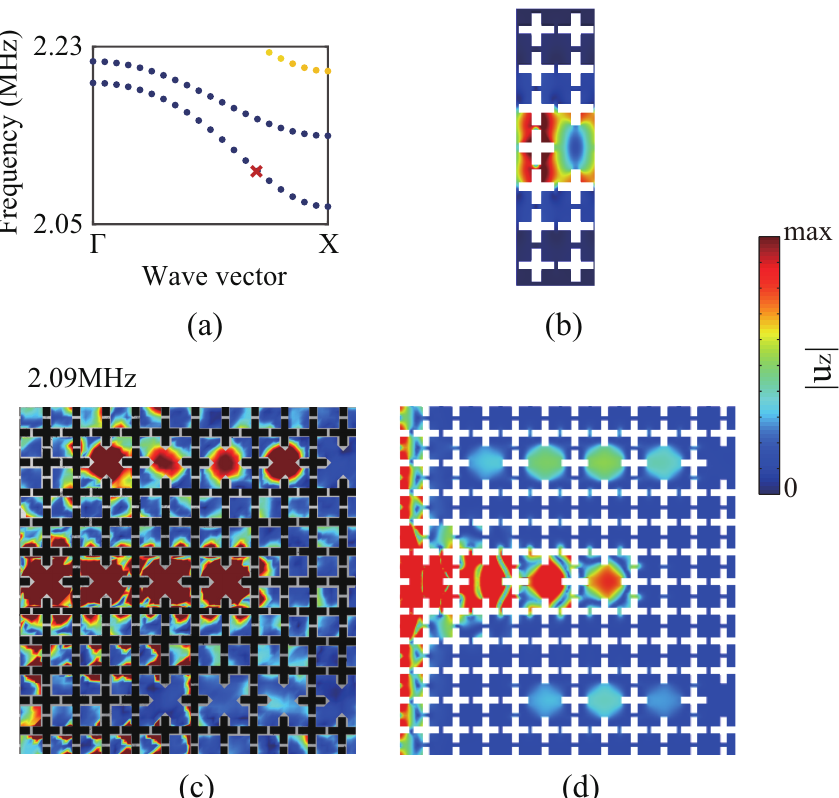
Figure 5. ( a ) Phononic band structure around 2.1 MHz. ( b ) the modal shape at the point marked with a red cross in ( a ) is depicted. Experimental ( c ) and numerical ( d ) out-of-plane displacement maps are shown at frequency 2.09